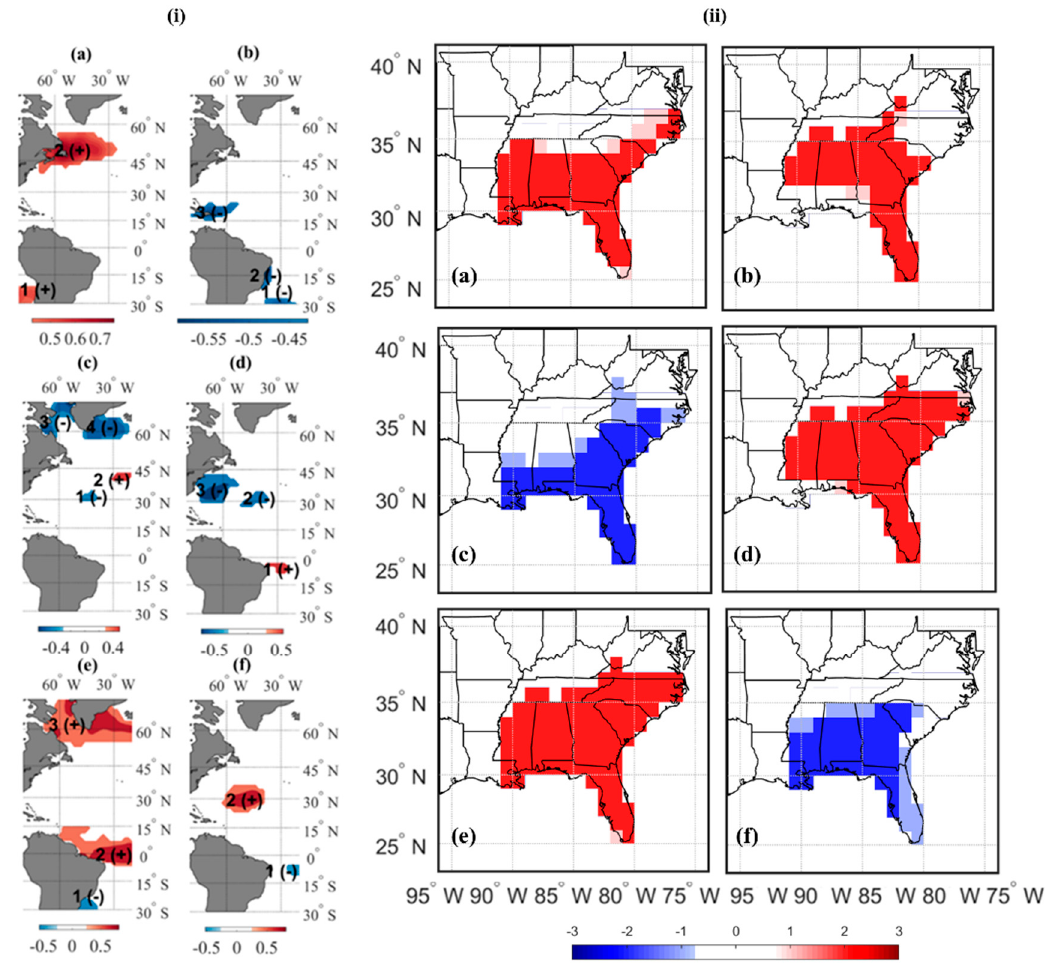
Figure 6. Heterogeneous correlation plots patterns between ( i ) Atlantic Ocean SST and ( ii ) PPT of the HUC-03 watershed region. ( a ) June-SST Aug-PPT; ( b ) July-SST Sept-PPT; ( c ) Aug-SST Oct-PPT; ( d ) Sept-SST Nov-PPT; ( e ) Oct-SST Dec-PPT; and ( f ) Nov-SST Jan-PPT.